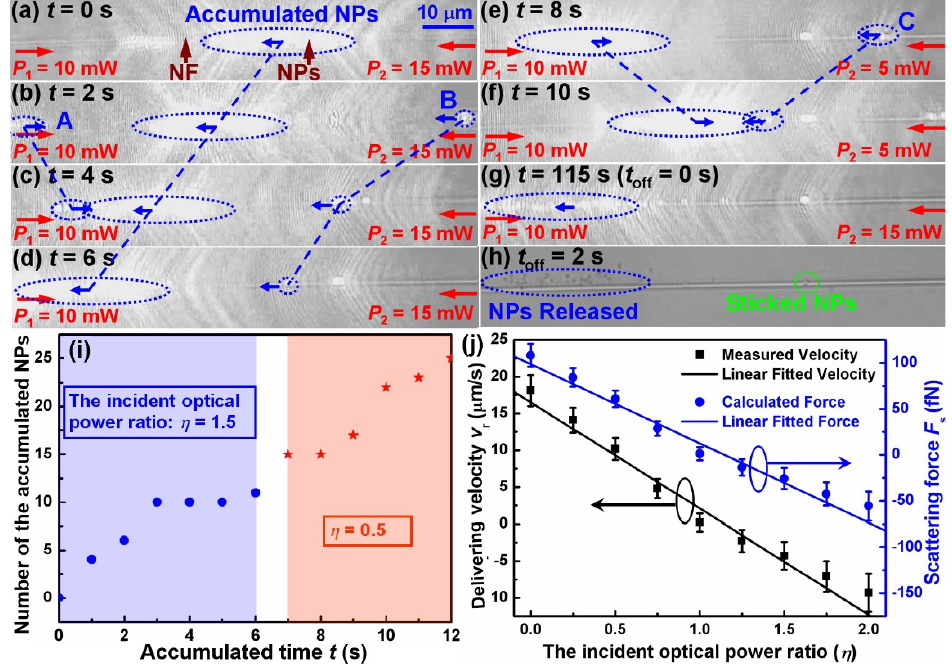
Figure 3. Bidirectional accumulation of NPs, delivery and release. ( a − d ) Accumulation of NPs (labeled as A, B) and delivery with P 1 = 10 mW and P 2 = 15 mW (i.e., η = 1.5). In this case, the accumulated NPs (blue dashed line circle, about 20 NPs that were accumulated at t = 0 s) were delivered in the negative direction (from right to left). ( e , f ) Accumulation of NPs (labelled as C) and delivery with P 1 = 10 mW and P 2 = 5 mW (i.e., η = 0.5). In this case, the accumulated NPs were delivered in the positive direction. ( g ) Microscope image of the laser just before being turned off (i.e., t off = 0 s, corresponding t = 115 s). ( h ) Release of the accumulated NPs at t off = 2 s. Detailed bidirectional accumulation, directional delivery and release process with the different incident optical power ratios from t = 0 to 117 s is shown in Media S2. ( i ) Number of the accumulated NPs with the corresponding accumulated time from t = 0 to 12 s. ( j ) Delivering velocity ( v r ) of NPs in the accumulation region and the corresponding optical scattering force acting on them as a function of η (keeping P 1 = 10 mW